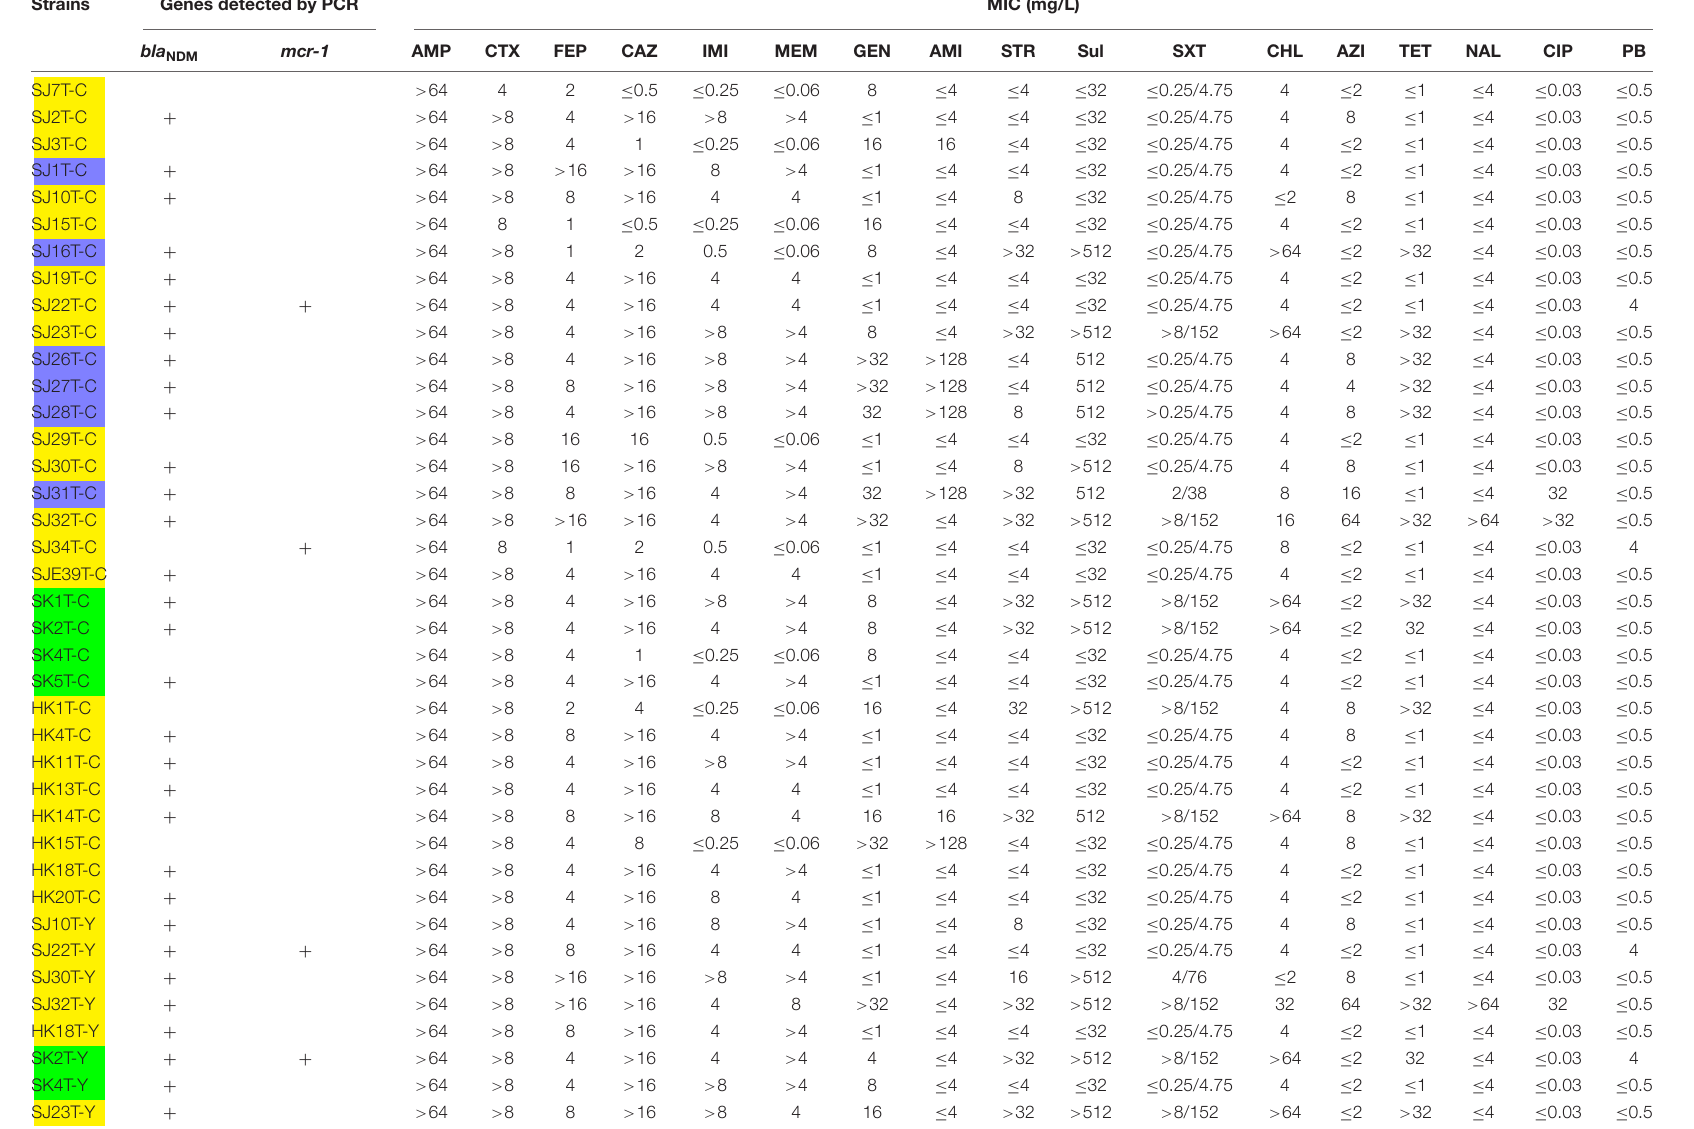
TABLE 2 | Characteristics of